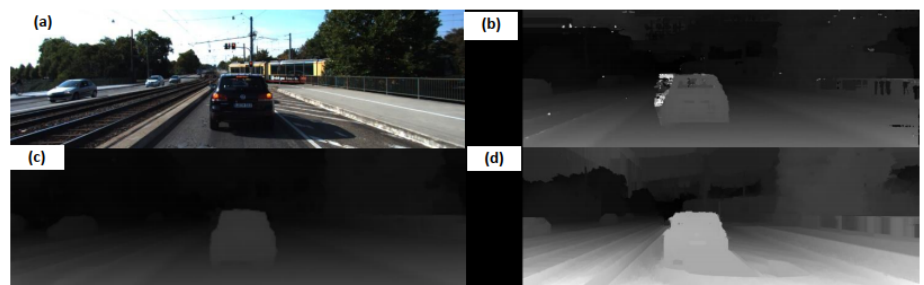
Figure 6. Results of disparity maps obtained using stereoscopic approaches: ( a ) original image; ( b ) stereo-baseline approach; ( c ) stereo-WLS filter and ( d )